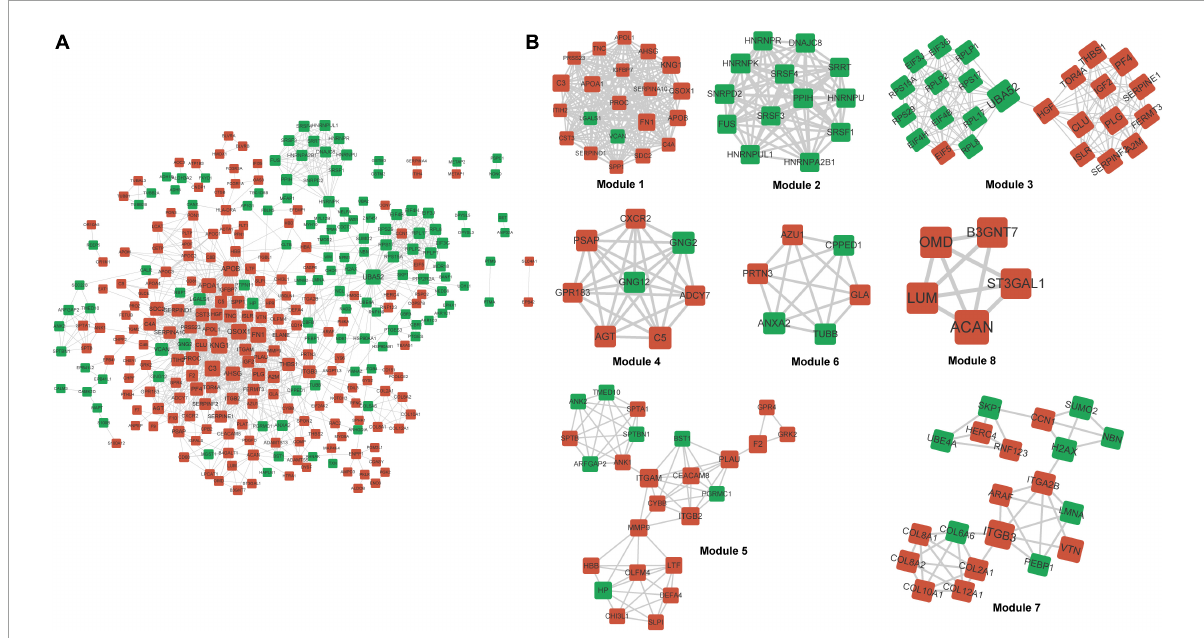
FIGURE5 Protein–protein interaction network and modules. (A) Differential PPI network. Red and green nodes upregulated nodes and downregulated proteins, respectively. (B) Significant modules identified from PPI network. PPI, protein–protein interaction.